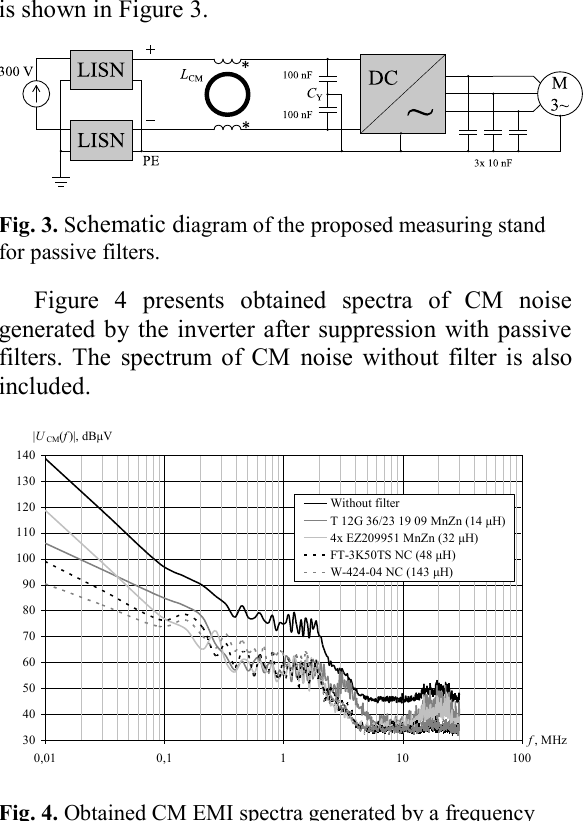
Fig. 5. Obtained CM EMI spectra generated by a frequency inverter without a filter and with a passive and hybrid filters with various core materials